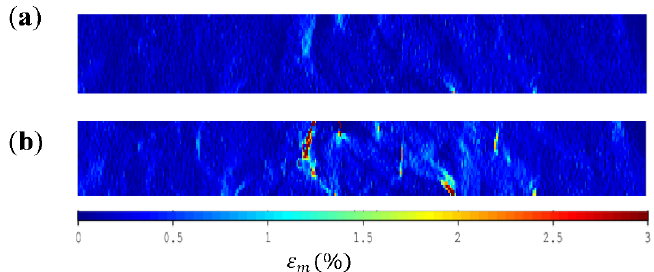
Figure 4. Strain field in gauge section of tensile specimen ( a ) at 20 MPa, ( b ) at 36 MPa.